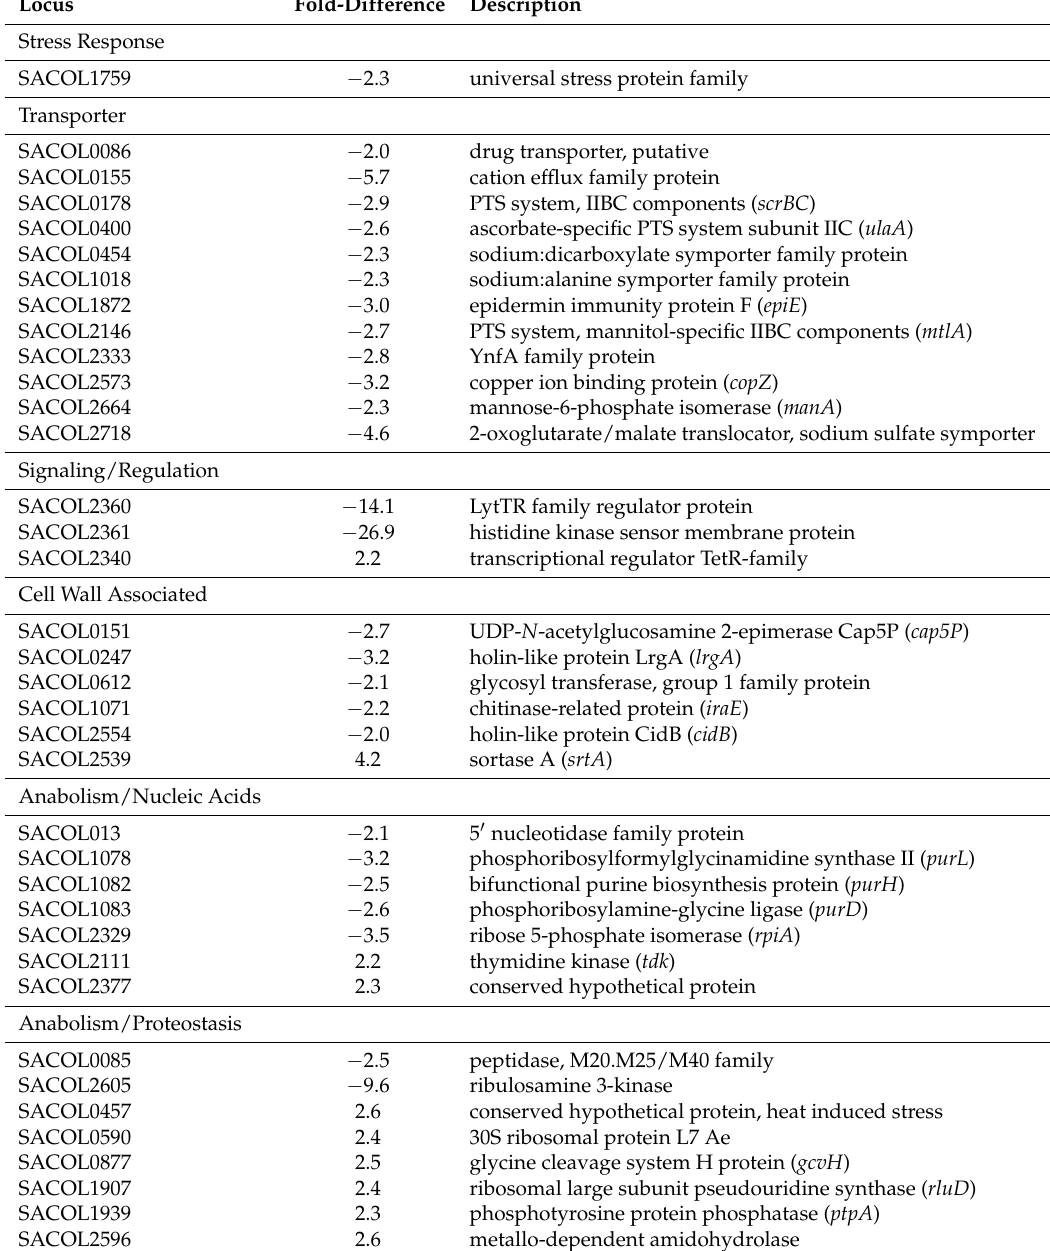
Table 2. Microarray analysis of genes dysregulated in S. aureus MW2 cells treated with 8 × the SK-03-92 MIC vs. untreated